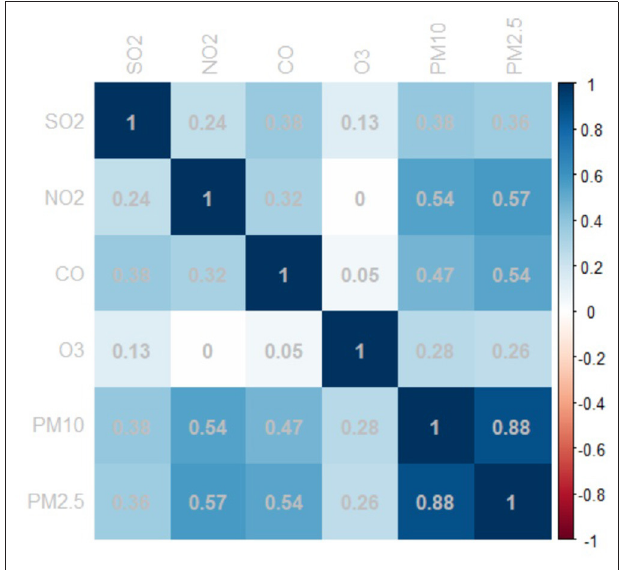
FIGURE 1 | Heatmap of spearman correlation coefficients between daily ambient air pollutants.